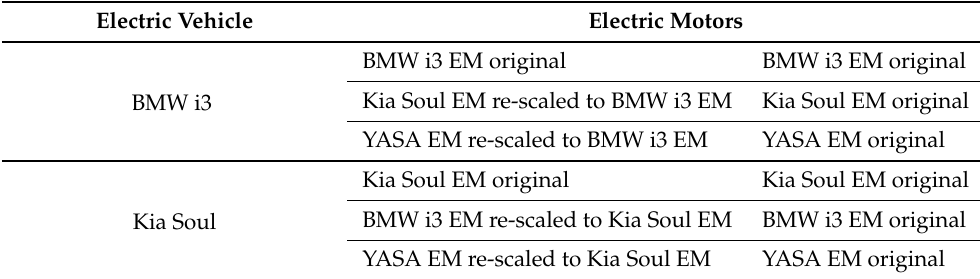
Table 3. Combination of the electric motors used in the simulation